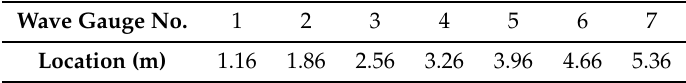
Table 7. Location of wave gauges from the